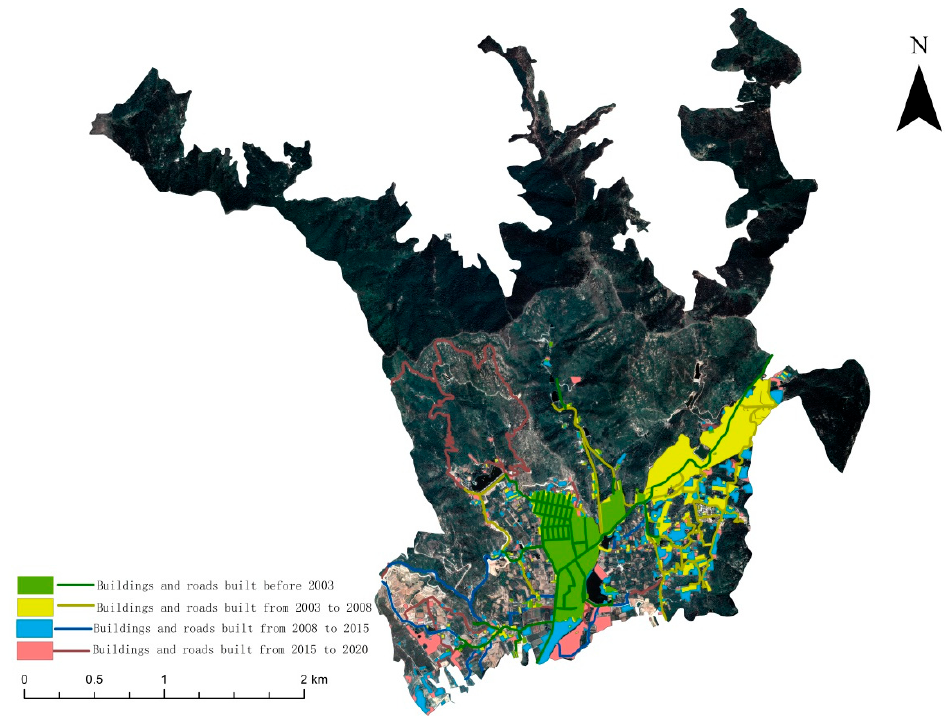
Figure 3. The spatial evolution process of Matao Village.